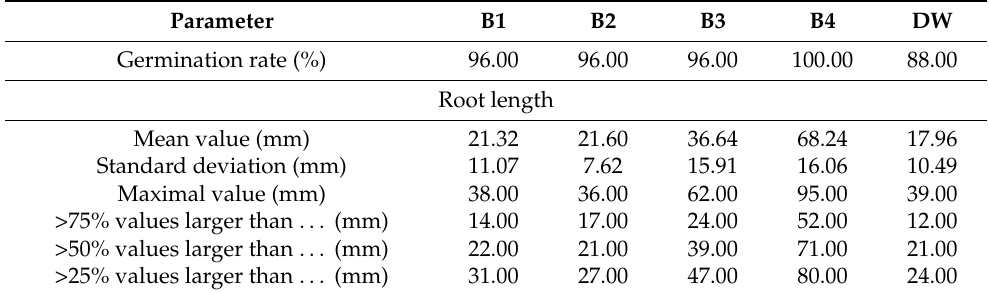
Table 5. Germination rate and values of root and shoot length for maize seeds treated with Bacillus sp. BioSol021 cultivation broth samples produced under different cultivation